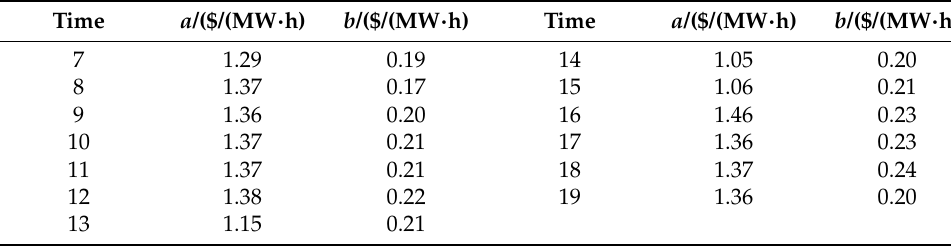
Table A6. Quotation factor for PV producer